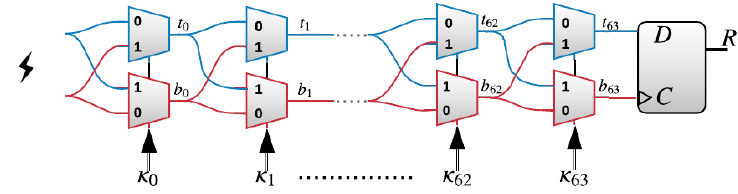
Figure 1. A 64-stage arbiter physical unclonable functions (PUF), consisting of two multiplexers at each stage, where the number of stages refers to the number of bits of the challenge ( k 63 , · · · , k 1 , k 0 )